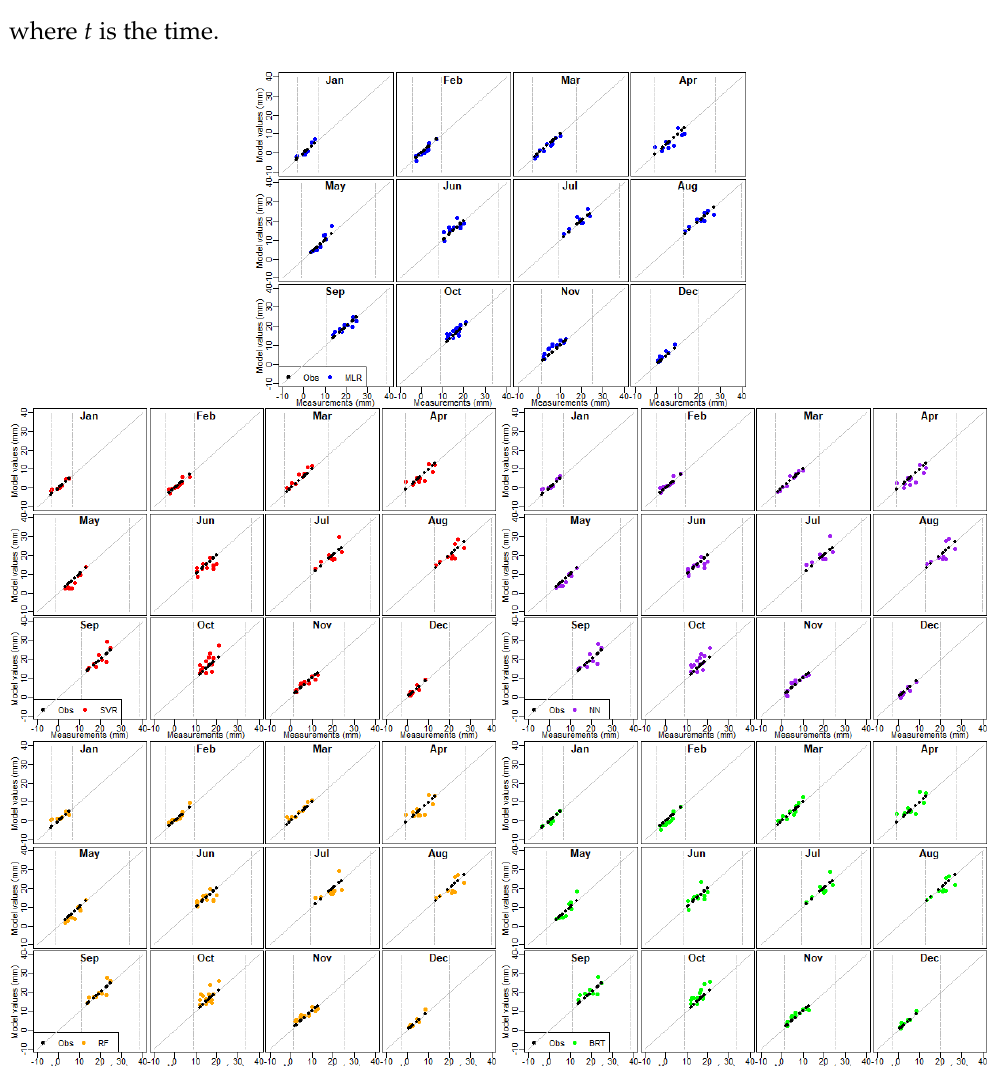
Figure 19. ML Model values vs measurements of radial displacements in FP5/5–277.07 m from 2015 to 2019 (predicted data). The vertical lines are the maximum and minimum measured values obtained during the training